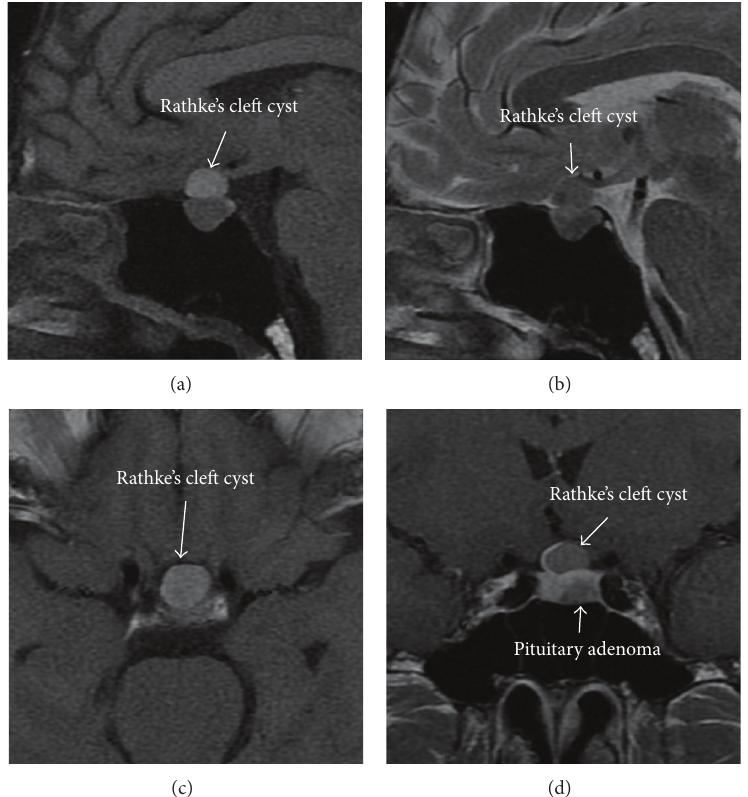
Figure 1: (a) Sagittal T1-weighted MRI of the head shows a suprasellar, high-intensity mass suspected to represent RCC. PA located below the RCC shows isointensity. (b) Sagittal T2-weighted MRI of the head shows isointense RCC and isointense PA. (c) Contrast-enhanced axial MRI shows nonenhancing RCC. In contrast, the normal pituitary gland shows strong enhancement. (d) Contrast-enhanced coronal MRI shows slight compression of the optic chiasma by RCC. And it shows an intrasellar PA of 9 mm in diameter located on the left of normal gland and suprasellar RCC of 12mm in diameter that compressed stalk to the right